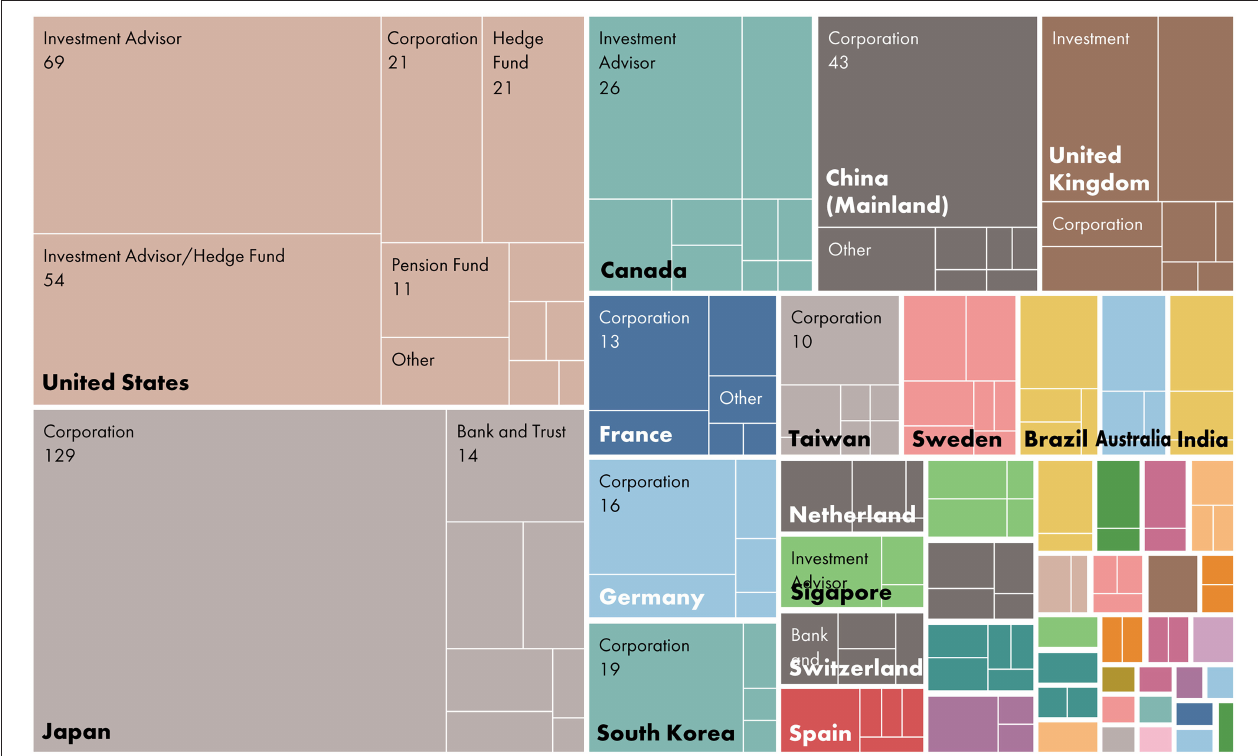
FIGURE 4 | Number of investors in the top 10% by country.